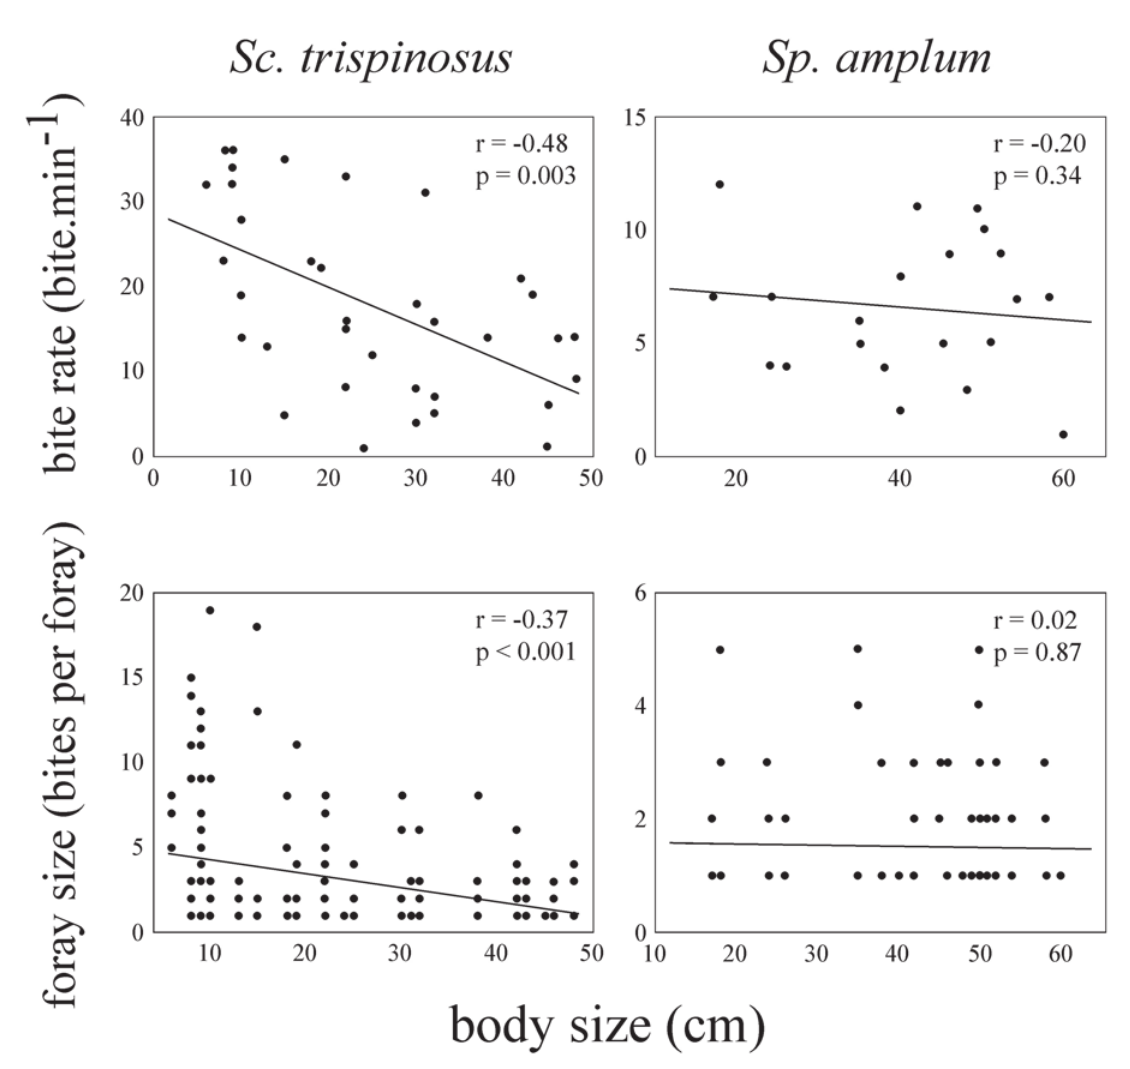
Fig. 5. Relationship between body size (total length) and bite rate (top) and body size and foray size (bottom) for Scarus trispinosus and Sparisoma amplum .